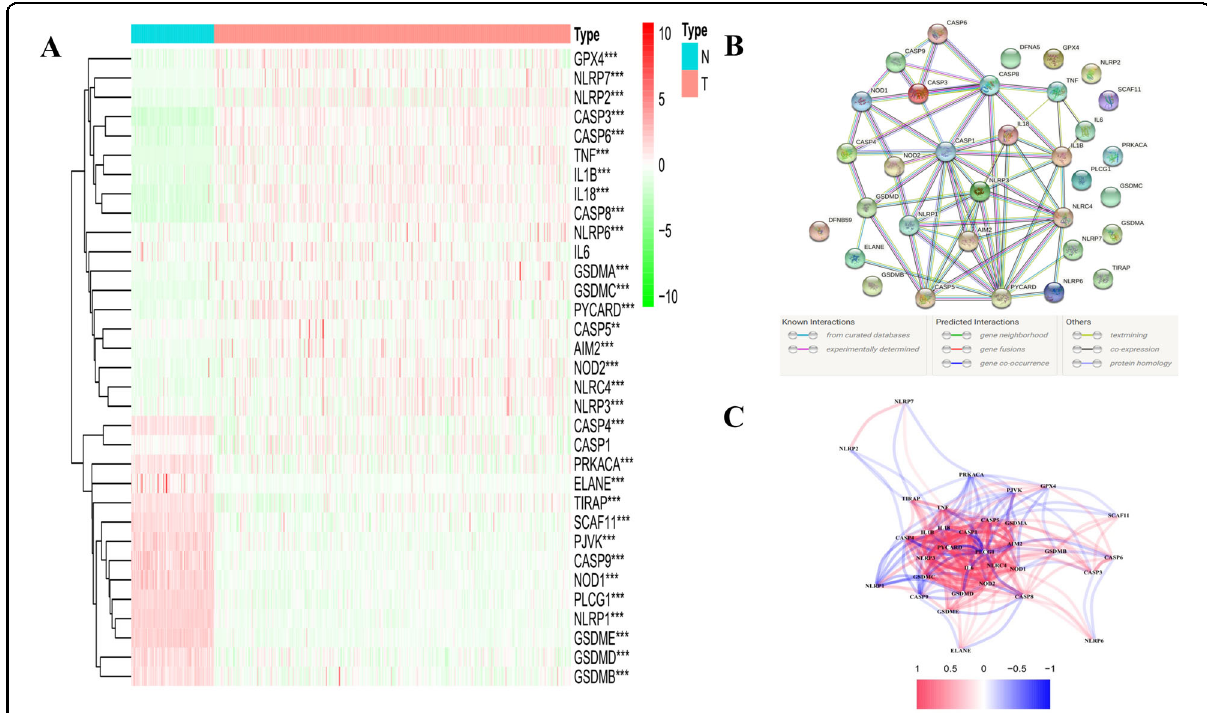
Fig. 1 Expressions of the 33 pyroptosis-related genes and the interactions among them. A Heatmap (green: low expression level; red: high expression level) of the pyroptosis-related genes between the normal (N, brilliant blue) and the tumour tissues (T, red). P values were showed as: ** P < 0.01; *** P < 0.001. B PPI network showing the interactions of the pyroptosis-related genes (interaction score = 0.9). C The correlation network of the pyroptosis-related genes (red line: positive correlation; blue line: negative correlation. The depth of the colours re fl ects the strength of the